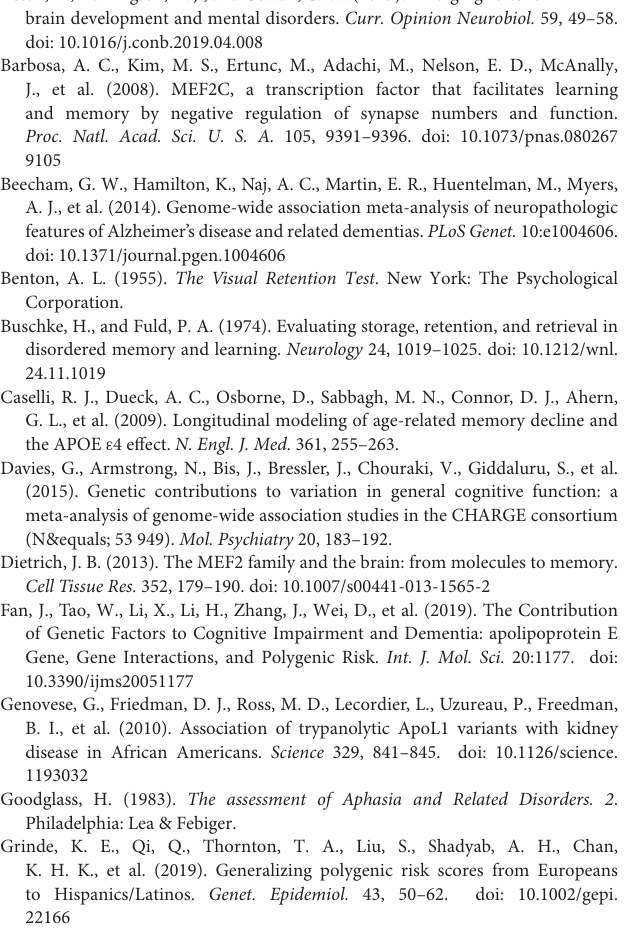
Supplementary Figure 1 | Linkage Disequilibrium for the SNPs included in the analyses. Supplementary Table 1 | WHICAP individual cognitive tests under each cognitive domain derived from factor